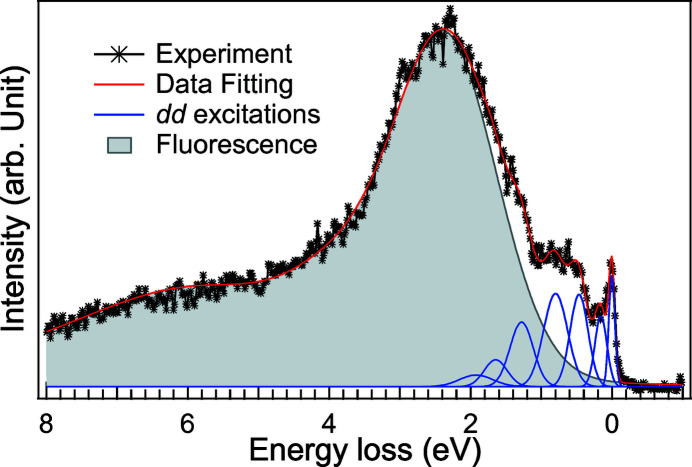
Fitting treatment of the RIXS spectra for LaCoO3/SrTiO3 film. Blue peaks are the Gaussian fitting profiles of dd excitation features. The gray area is the fitting profile for the fluorescence feature.